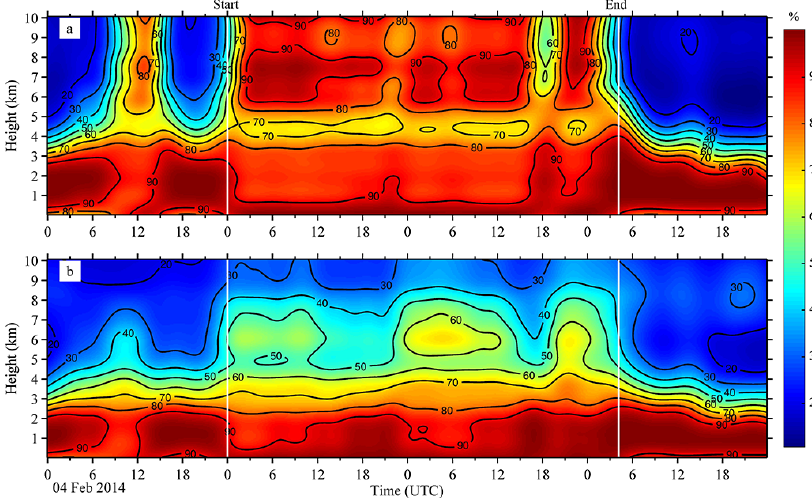
Figure 8. Same as Fig. 6 but for relative humidity